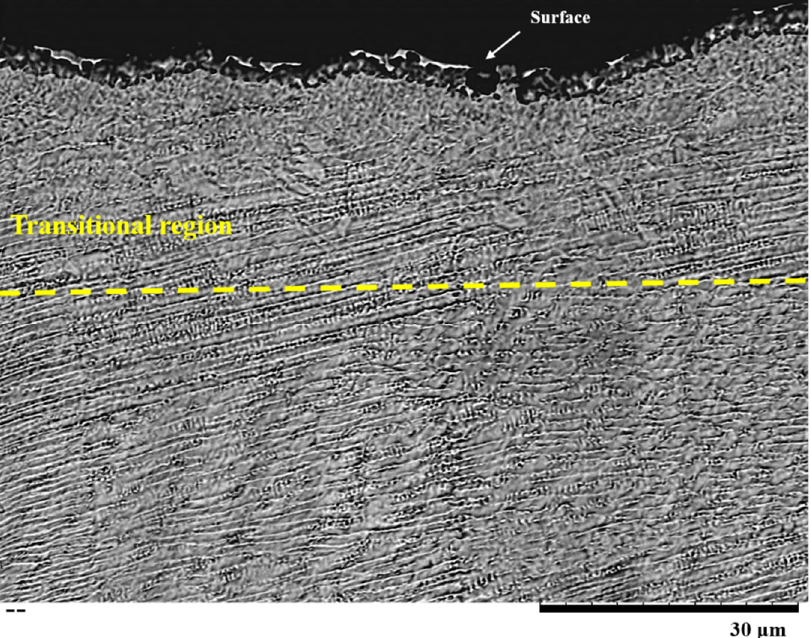
Figure 10. SEM image showing the microstructure near to the surface area of the sample heated to 1000 °C with 100 °C/s and dwell time 10 s followed by cooling at a constant rate of 65 °C/s.